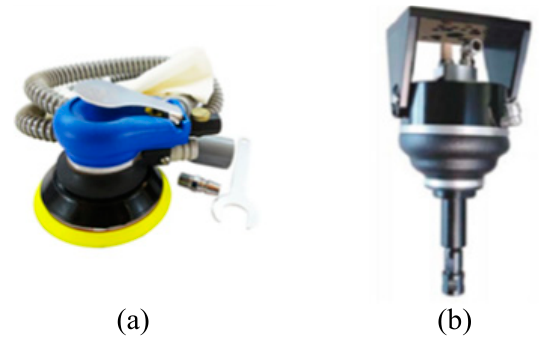
Figure 5. Pneumatic grinding equipment. ( a ) Pneumatic polishing machine. ( b ) Pneumatic debur- ring tool.